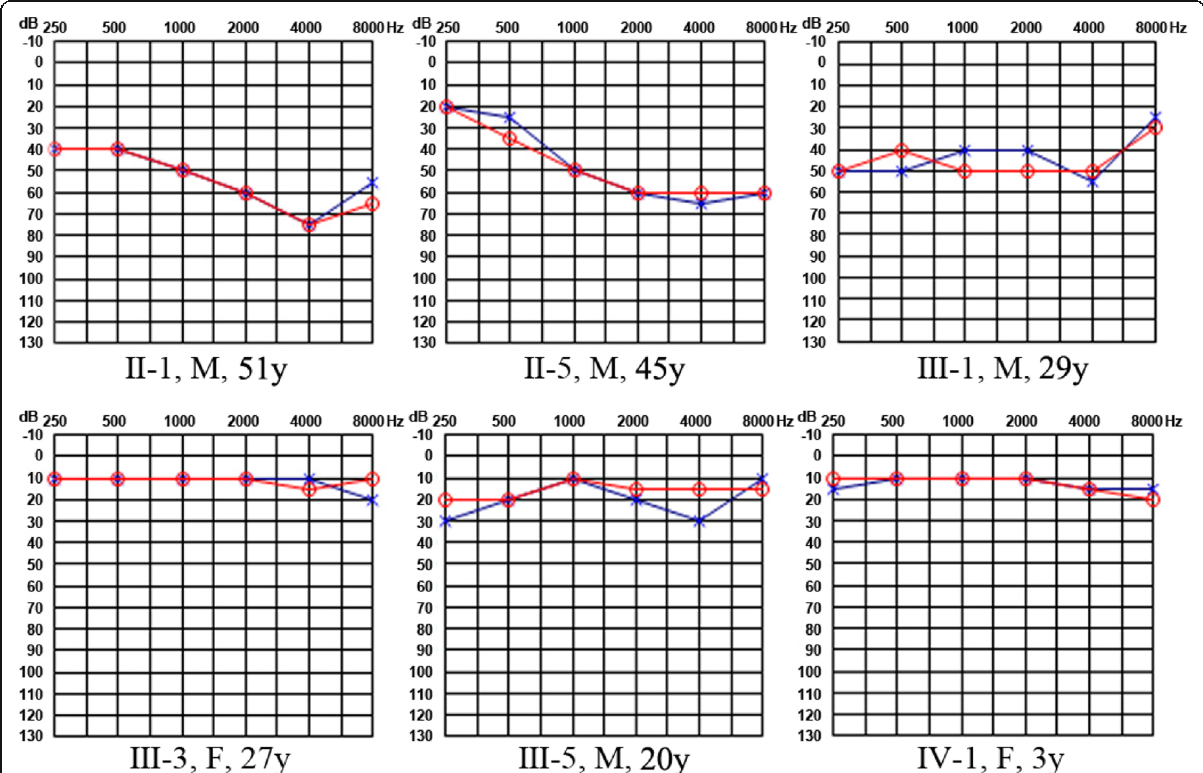
Fig. 2 Bilateral pure tone audiograms from individuals in this family. Individual IV-1 was examined by behavior observation audiometry (circles in the audiograms represent the right air conduction thresholds, and crosses, the left ear)